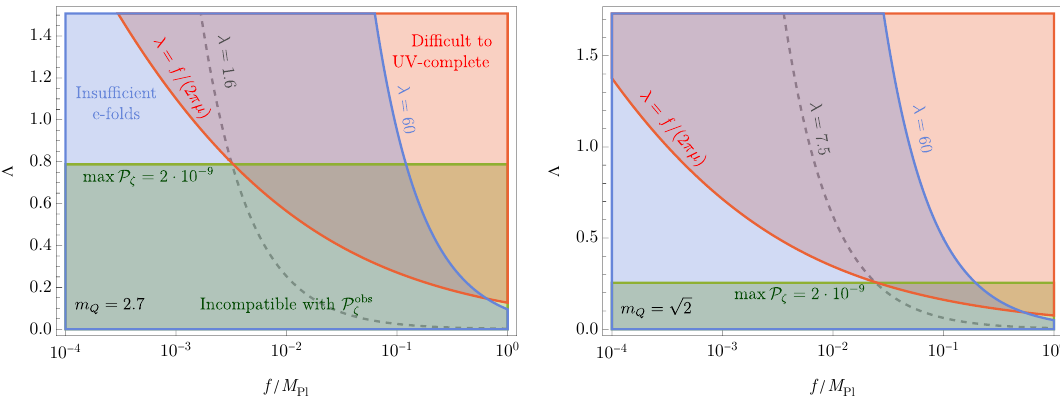
√ Figure 3 . Exploring the Λ 2 ≤ Λ crit ∼ 2 (see (4.6)) solutions with various constraints. g = 0 . 014 and H = 8 . 2 · 10 − 6 for both panels. The red shaded region is forbidden by clockwork (5.9). The blue shaded region excludes point with N χ < 10 (5.10). The green shaded area doesn’t produce correct values for P ζ . The small area at the bottom right of both panels, trapped between the red and blue curves, corresponds to f values from (5.4). Not that all regions outside of the blue shaded area correspond to f ∼ 10 − 1 M Pl . (Left Panel) Choosing the benchmark value m Q = 2 . 7 allows us to lower Λ min down to 0 . 74 (see (4.8)). No clockworkable solution with λ ≥ 60 and correct P ζ exists. √ (Right Panel) Lowering benchmark values to m Q = 2 doesn’t resolve the UV completion